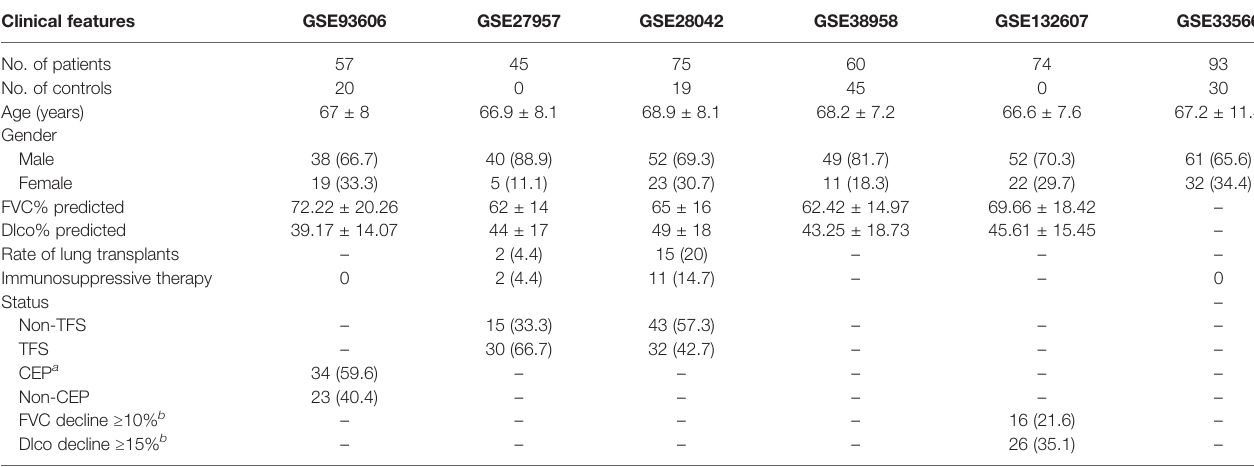
TABLE 1 | The clinical features of patients with IPF